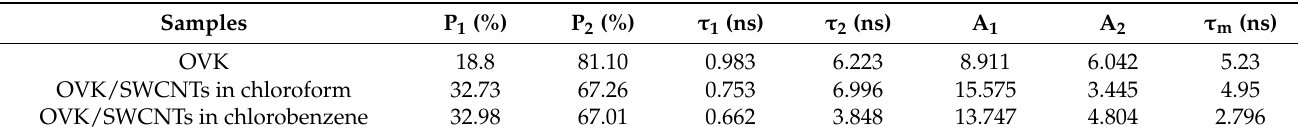
Table 1. Decay parameters of OVK/SWCNT nanocomposites [18].